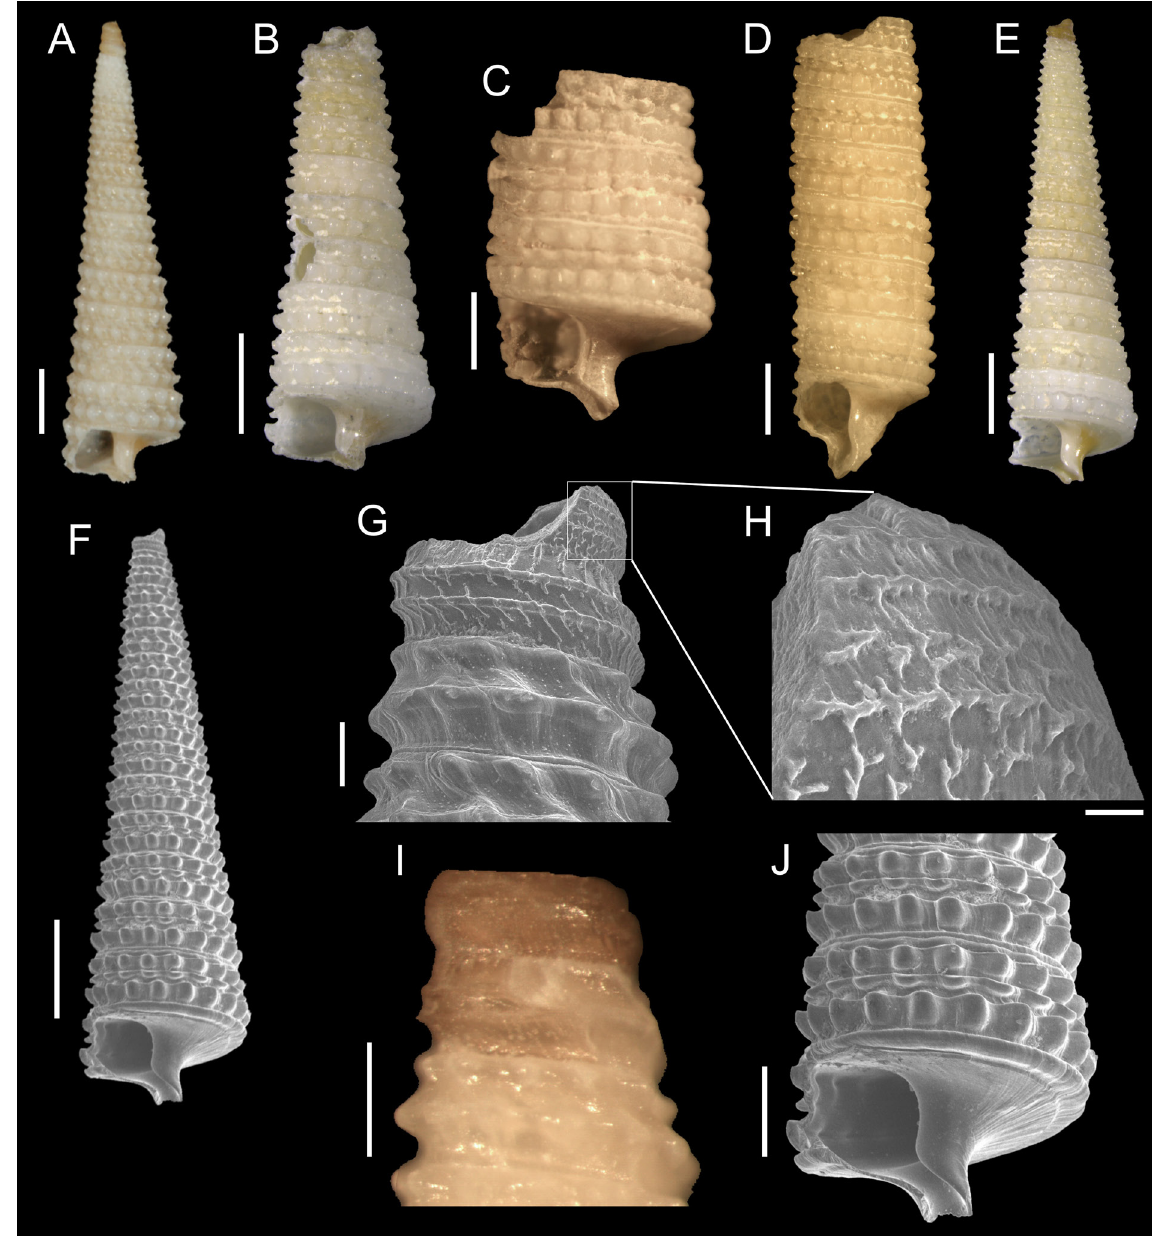
Fig. 10. Monophorus caracca (Dall, 1927) comb. nov. A . USNM 108343, lectotype, 7.1 mm. B–E . MNHN*, 4.42 mm, 6.84 mm, 4.50 mm and 5.74 mm, respectively. F–J . Same shell as E. Scale bars: A–F = 1 mm; G = 100 µm; H = 20 µm; I = 250 µm; J = 500 µm .